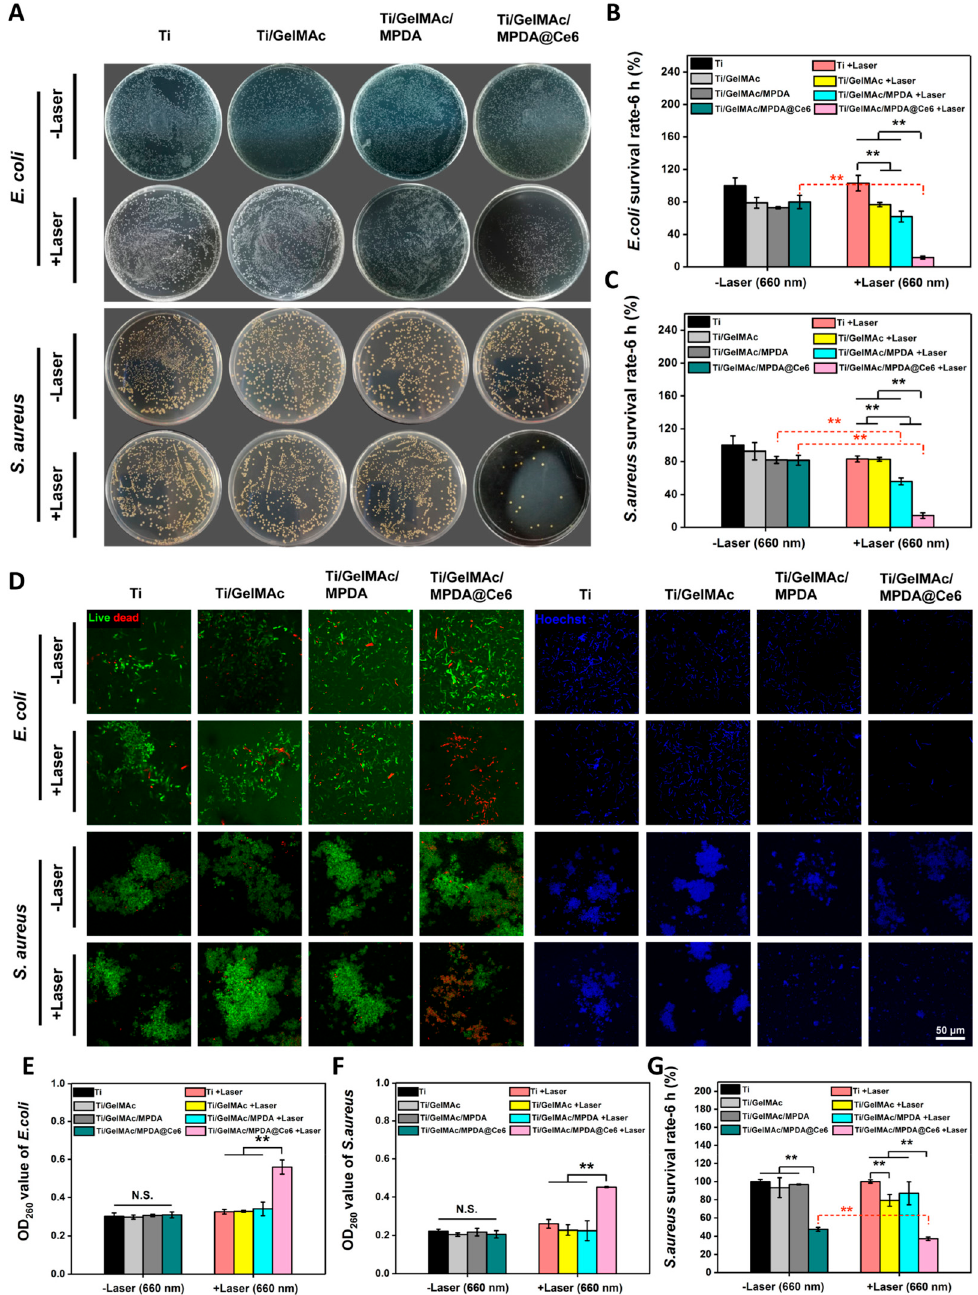
Figure 8. In vitro antibacterial tests. In these tests, S. aureus and E. coli were incubated with different samples upon laser irradiation (1 W/cm 2 ) and cultured for 24 h. ( A ) Bacterial colony plate counting photos. ( B , C ) The corresponding quantitative analysis according to colony plate counting. ( D ) Representative images of live/dead staining and adhesion tests. ( E , F ) OD260 values of S. aureus and E. coli after incubation with different samples. ( G ) MTT assay measuring the viability of S. aureus after laser irradiation and further 6 h of incubation (100 mW/cm 2 ) (n = 6, ** p < 0.01) [131].